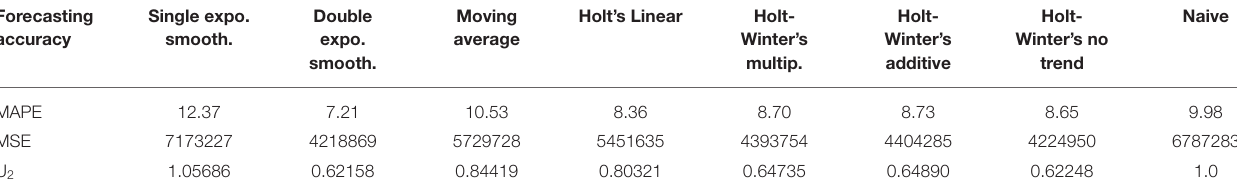
TABLE 7 | The results of forecasting (fourth approach and product without shortage). Forecasting accuracy